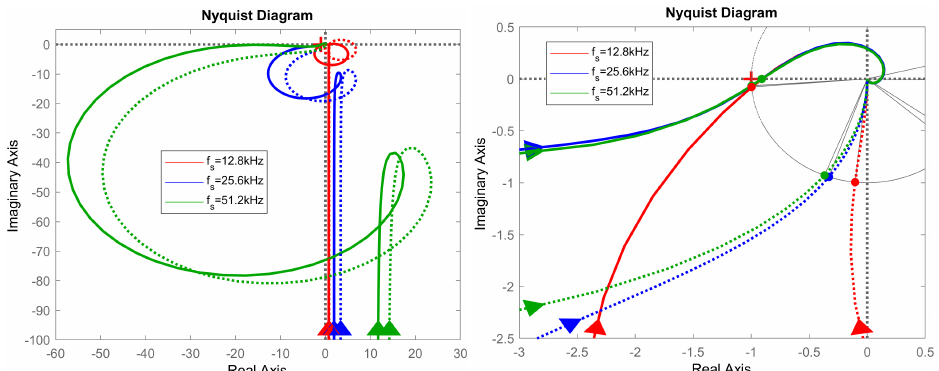
Figure 14. Solid lines: Nyquist plots for the systems depicted in Figure 13 with ∆ A = 1.1: f s = 12.8 kHz: k = 9, ∆ φ = 4.48 deg, f 1 = 1473 Hz, f π = 1566 Hz; f s = 25.6 kHz: k = 35, ∆ φ = 3.86 deg, f = 2447 Hz, f π = 2665 Hz; f s = 51.2 kHz: k = 144, ∆ φ = 3.75 deg, 1 f 1 = 4721 Hz, f π = 5142 Hz; Dotted lines: for the system with the hypothetical no-delay controller C ∗ ( s ) : f s = 12.8 kHz: ∆ φ = 84 deg, f s = 25.6 kHz: ∆ φ = 70.7 deg, f s = 51.2 kHz: ∆ φ = 68.4